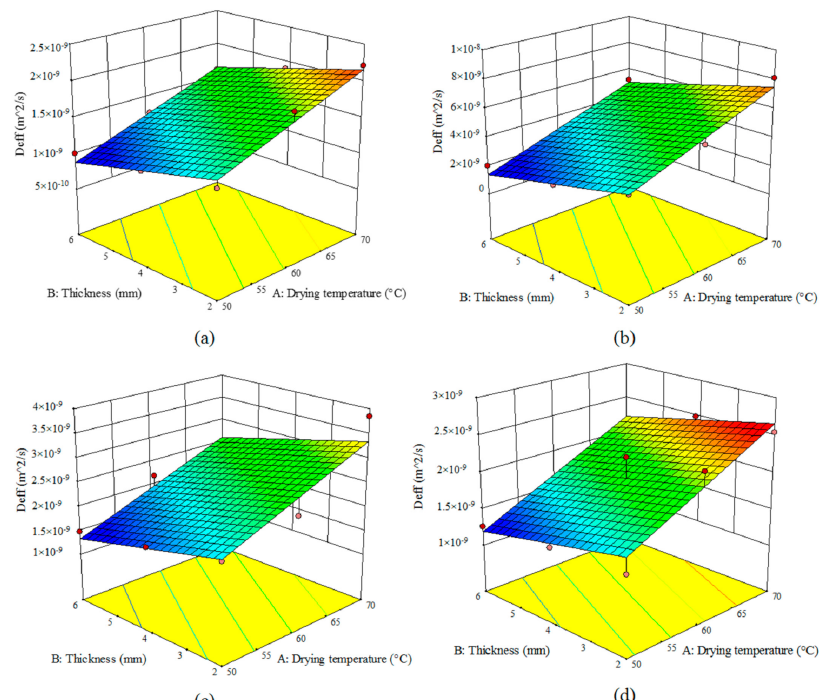
Figure 2. Effect of the drying temperature and sample thickness on the effective moisture diffusivity coefficient ( D eff ) (m 2 /s) of the turnip slices dried under an HCIR dryer with various pretreatments ( a ) control, ( b ) microwave, ( c ) ultrasound, and ( d ) blanching.